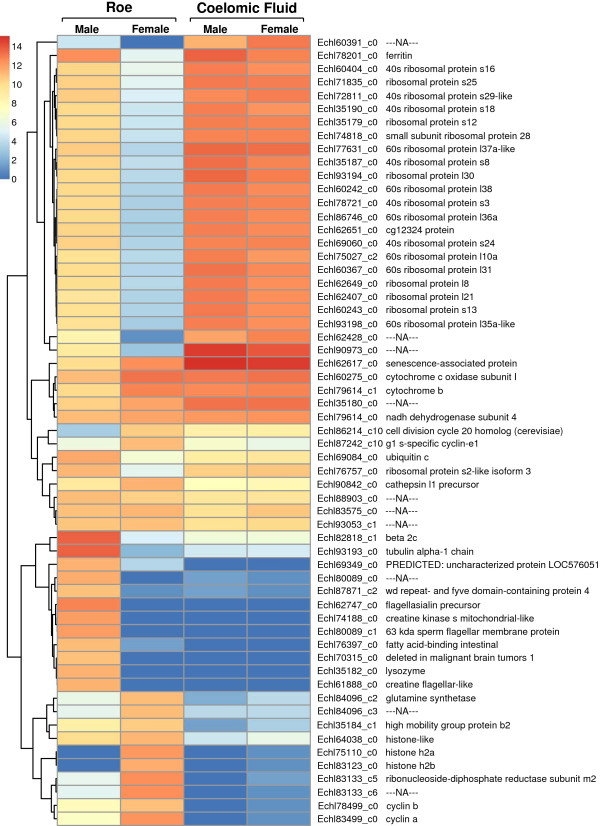
Heatmap of most highly expressed transcripts from each tissue. Heatmap showing the log2 FPKM values of most abundant transcripts. The colour legend shows the log2 FPKM values each represents. Rows were clustered based on Euclidean distance.